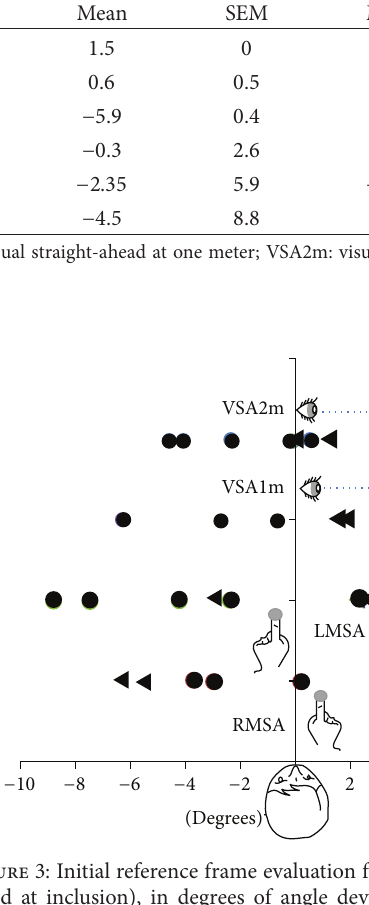
𝑝 = 0.15 ). Average values obtained for right and left